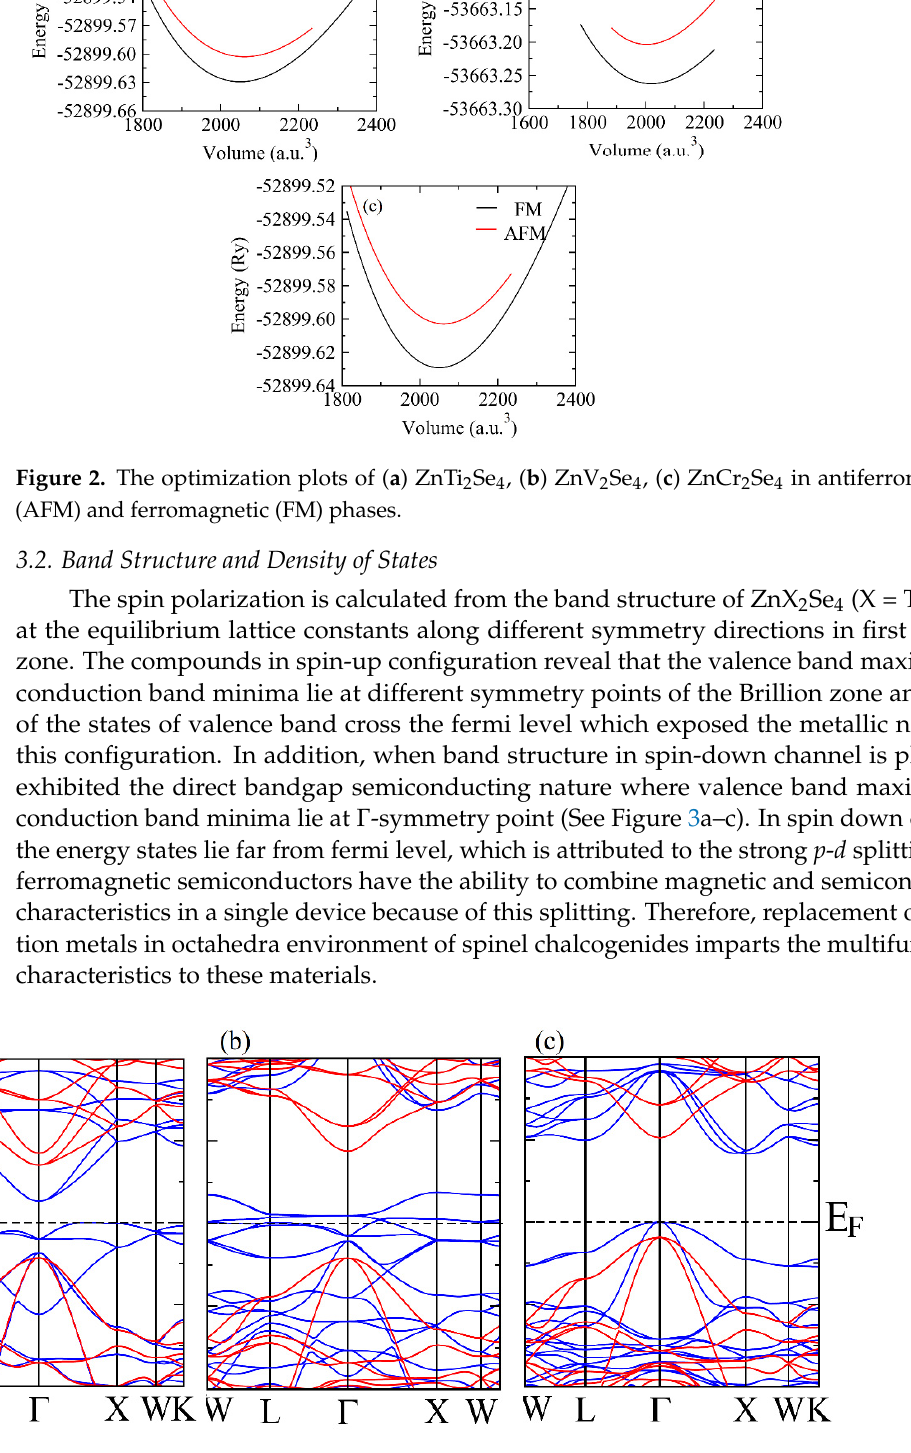
Figure 3. The band structures for up -spin channel (blue color) and down- spin channel (red color) of ( a ) ZnTi 2 Se 4 , ( b ) ZnV 2 Se 4 and ( c ) ZnCr 2 Se 4 . ( a ) ZnTi 2 Se 4 , ( b ) ZnV 2 Se 4 and ( c ) ZnCr 2 Se 4